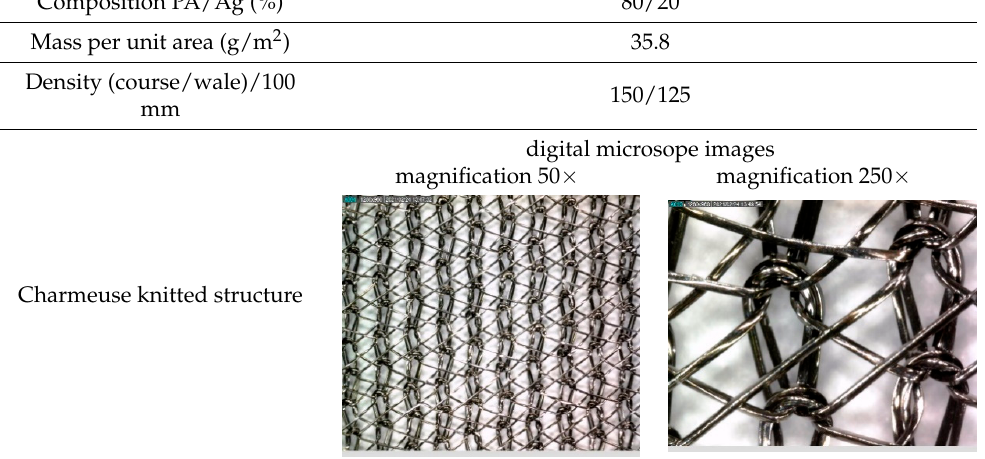
Table 1. Specifications of the shielding conductive knitted fabric (PA/Ag).